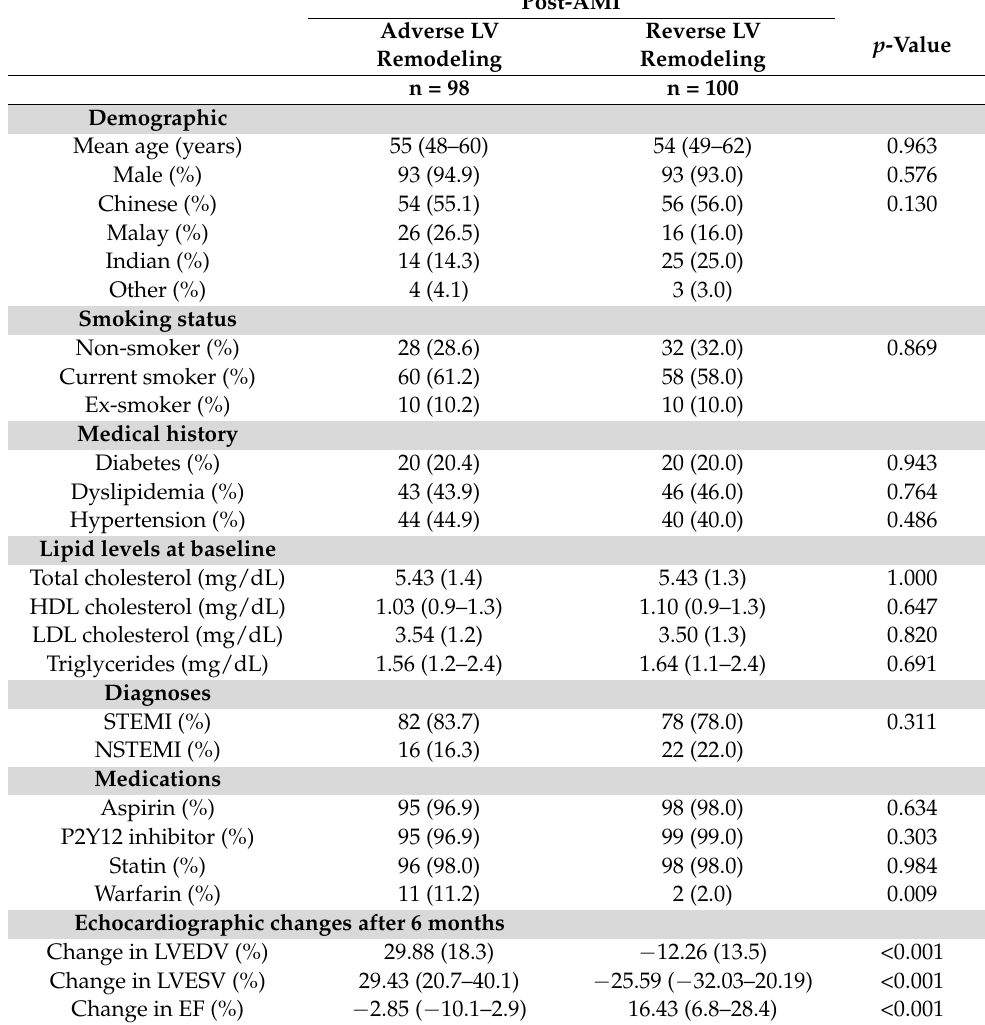
Footnotes for Table 1: Continuous data are presented as mean ± SD or median ± IQR, and statistical analysis of continuous data was performed using unpaired Student’s t -test or Mann–Whitney U test. Categorical variables are presented as %, with differences between the groups tested with χ 2 . Abbreviations: AMI, acute myocardial infarction; LV, left ventricular; HDL, high density lipoprotein; LDL, low density lipoprotein; STEMI, ST-elevation myocardial infarction; NSTEMI, non-ST-elevation myocardial infarction; LVEDV, left ventricular end diastolic volume; LVESV, left ventricular end systolic volume; EF, ejection